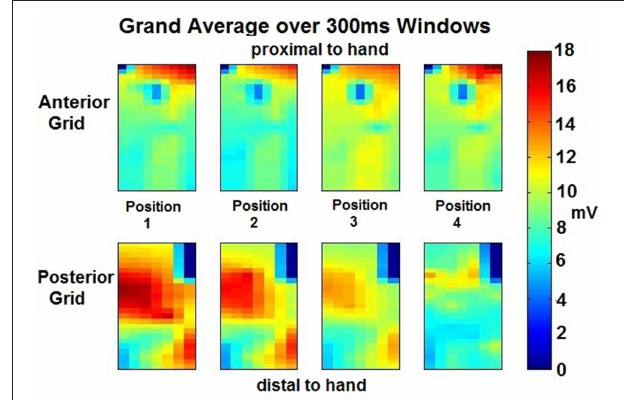
FIGURE 4 | Grand Averaged Windows for Feature Extraction per position per ROI—The RMS values were obtained during 11 windows (300ms each) of the isometric effort were averaged for each position of the thumb per grid placed on the forearm ROI. From the anterior grid (top 4 images), a different amplitude exertion is appreciated proximal to the hand, for the different thumb movements. A central exertion is appreciated which amplitude also varies depending on the position. An electrode at the center-top of these four images seems to have a clear detrimental in amplitude, this may be due to no activity on that area but most likely, and given the smooth transitions across the electrodes, it may be due to an electrode miss-contact. Similar analysis can be performed to the posterior grid (bottom 4 images). Clear amplitude difference is appreciated across positions, going from high amplitude to low amplitude from position 1 to 4. Position 4 seems to have different exertion and muscles involved than the rest of the positions, the amplitude is lessened but there are two sources of exertion at similar levels in amplitude and